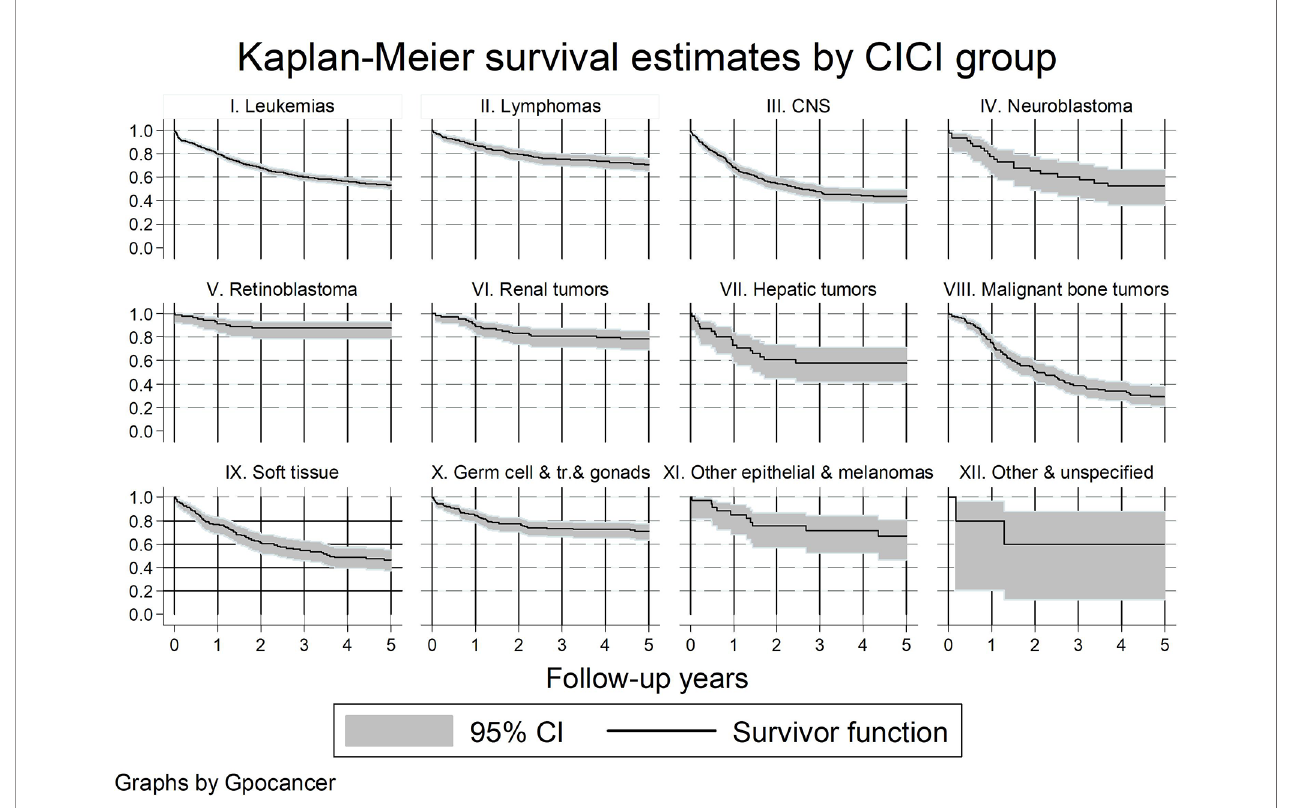
FIGURE 2 | Kaplan – Meier survival curves by cancer diagnosis